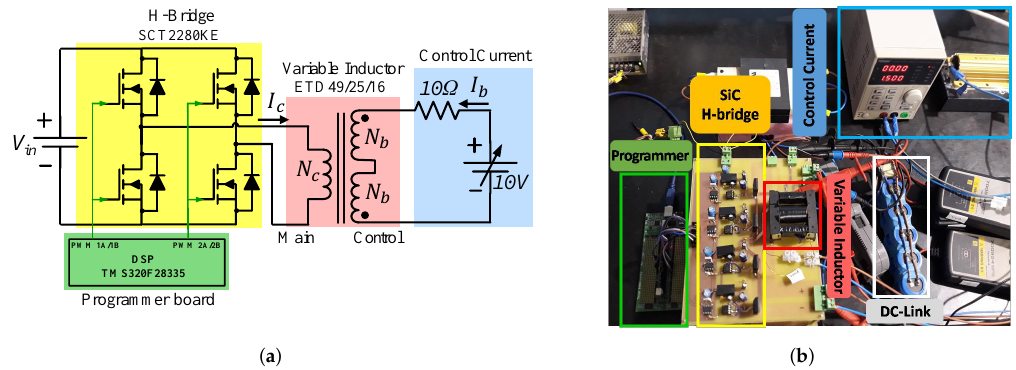
Figure 14. Experimental setup used to test the variable inductor under small and large-signal analyses. ( a ) Circuit diagram, and ( b ) test